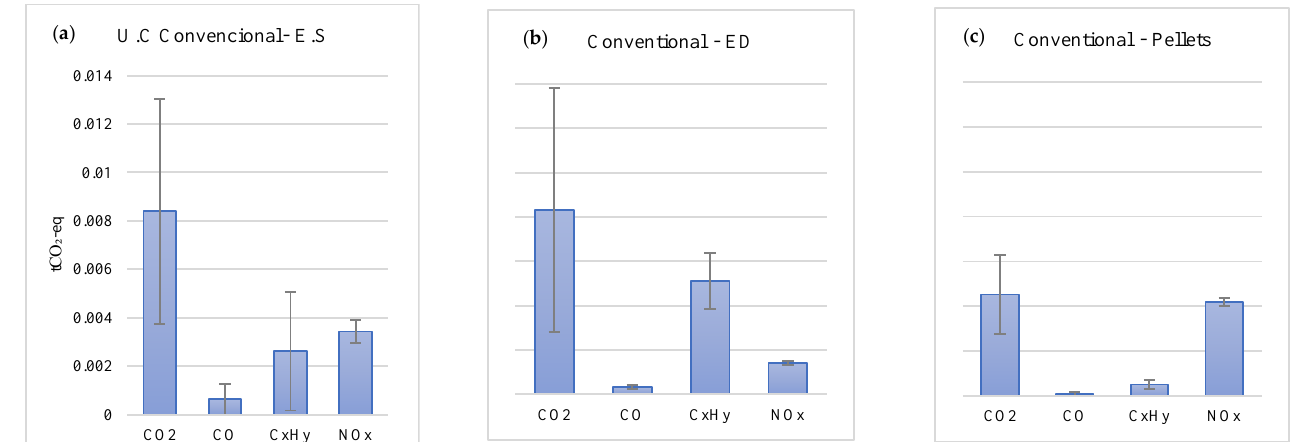
Figure 4. Emission factors for the Chongololo ( a and b ) and forced air ( c and d ) CUs, considering the firewood biomass of two forest species E. saligna (ES) and E. dunnii (ED).